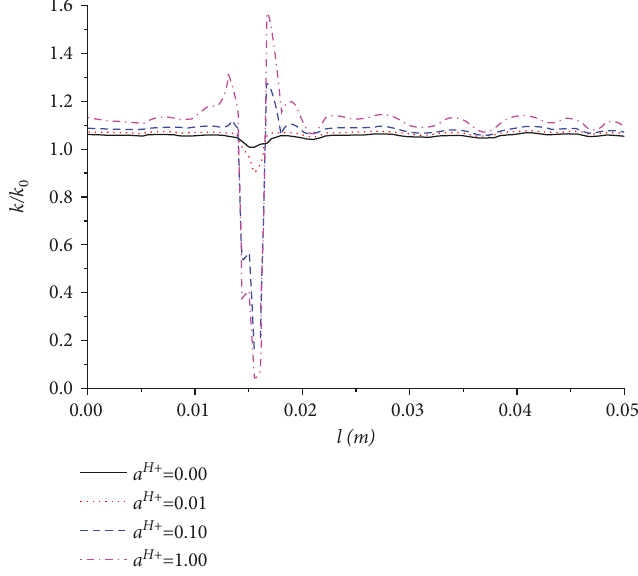
Figure 20: Evolution of the permeability ratio k / k